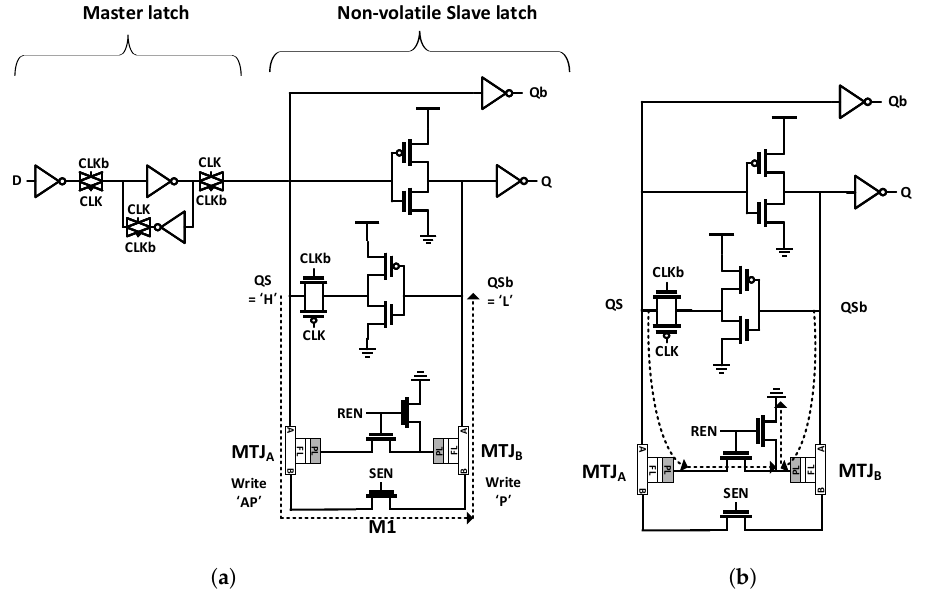
Figure 2. Schematic of the proposed CR-FF: ( a ) Storing operation (Q = 1), ( b ) Restoring operation (slave latch only).